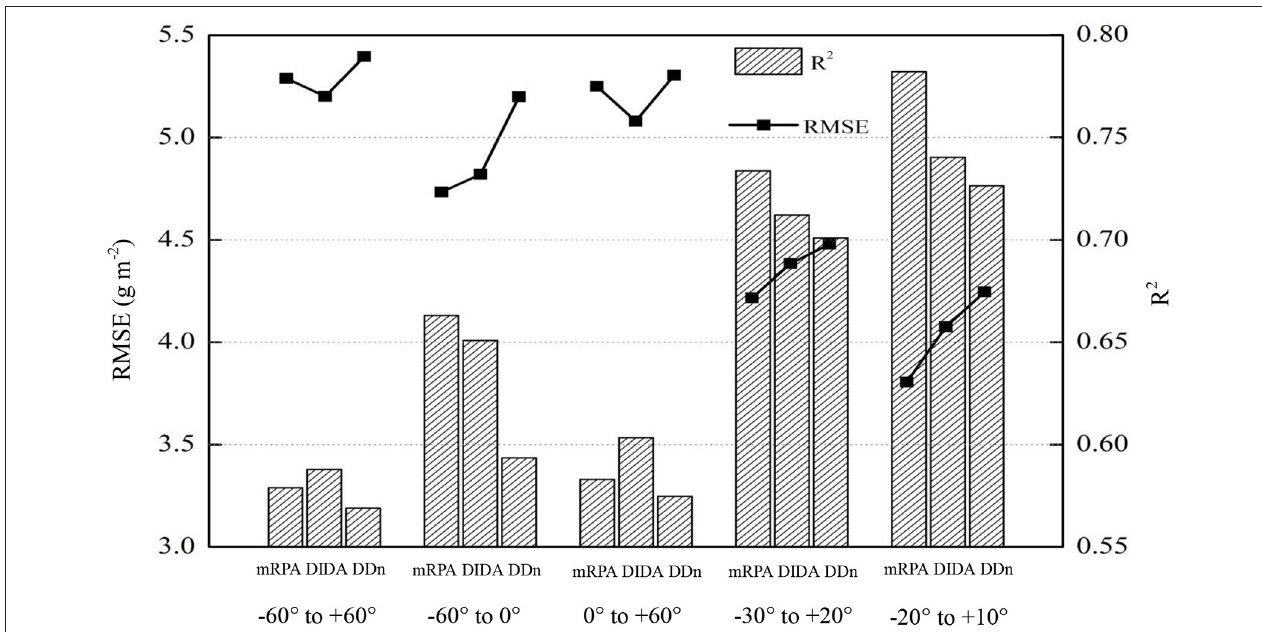
FIGURE 11 | Comparison of the predictive ability of the indices within five kinds of view zenith angles combinations in terms of aerial N uptake.